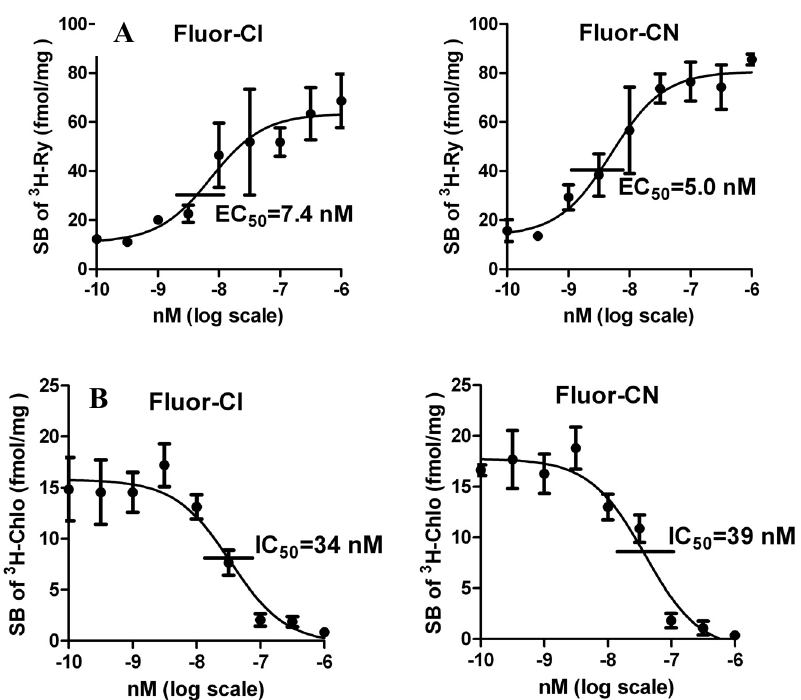
Figure 2. Effects of fluorescent ligands on specific binding of [ 3 H]Ry and [ 3 H]Chlo in Musca muscle membrane. ( A ) Stimulation of [ 3 H]Ry binding (EC [ 3 H]Chlo binding (IC 50